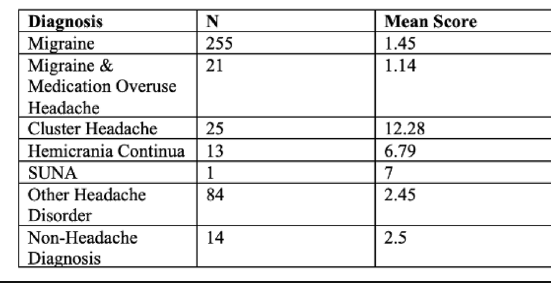
Table 1 (abstract P19). Average core by headache